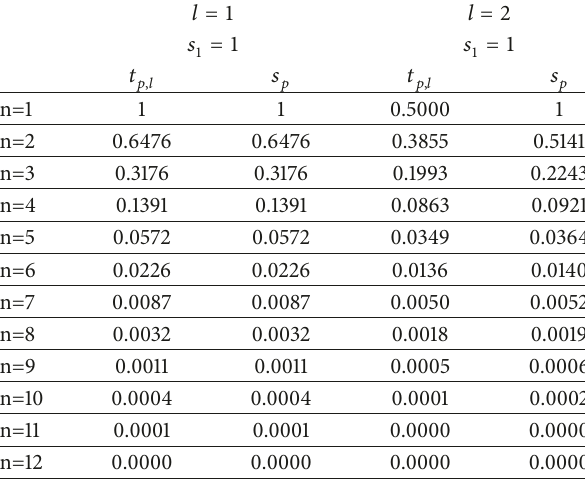
Table 1: The values of 𝑡 𝑝,𝑙 and 𝑠 𝑝 with initial values 𝑠 1 = 1 when